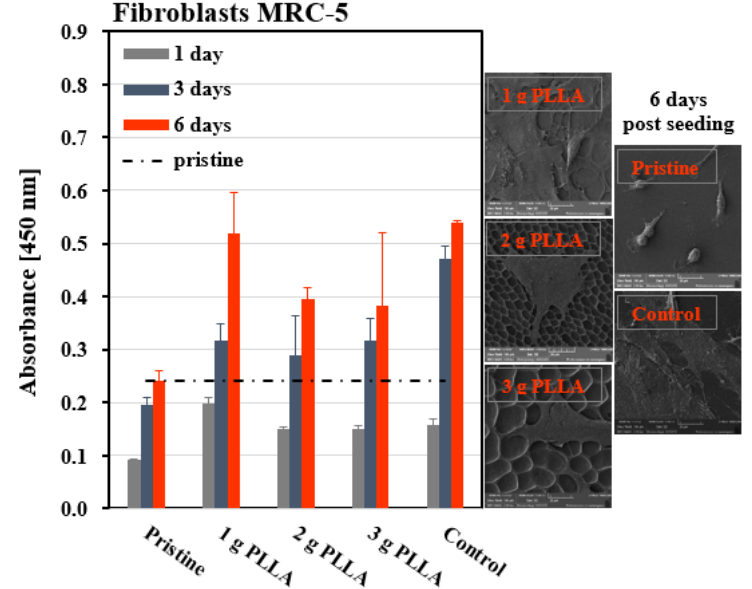
Figure 6. Viability of human primary lung fibroblasts (MRC-5) and corresponding images (100 × 100 µm 2 ) obtained from scanning electron microscopy (SEM) of unmodified FEP (Pristine); standard tissue polystyrene (Control); and FEP foils modified at 8 W and 240 s and then immersed in polymer solution containing 1, 2, or 3 g of PLLA.